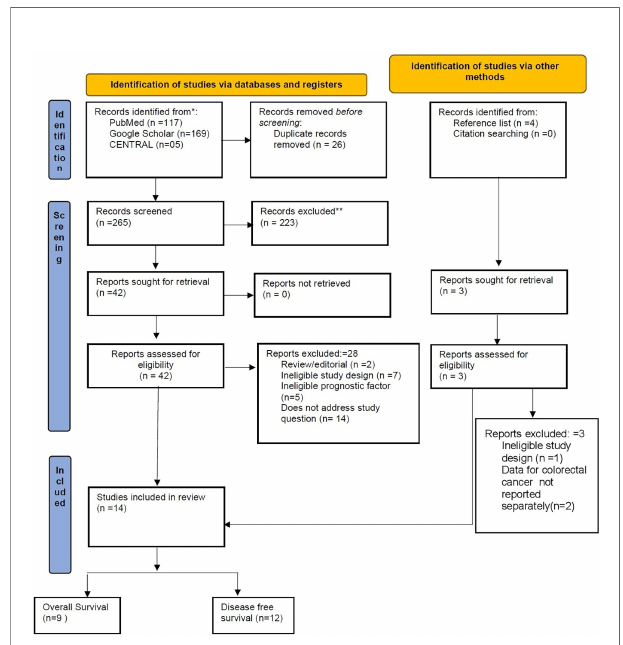
FIGURE 1 | Study fl ow diagram representing selection process of